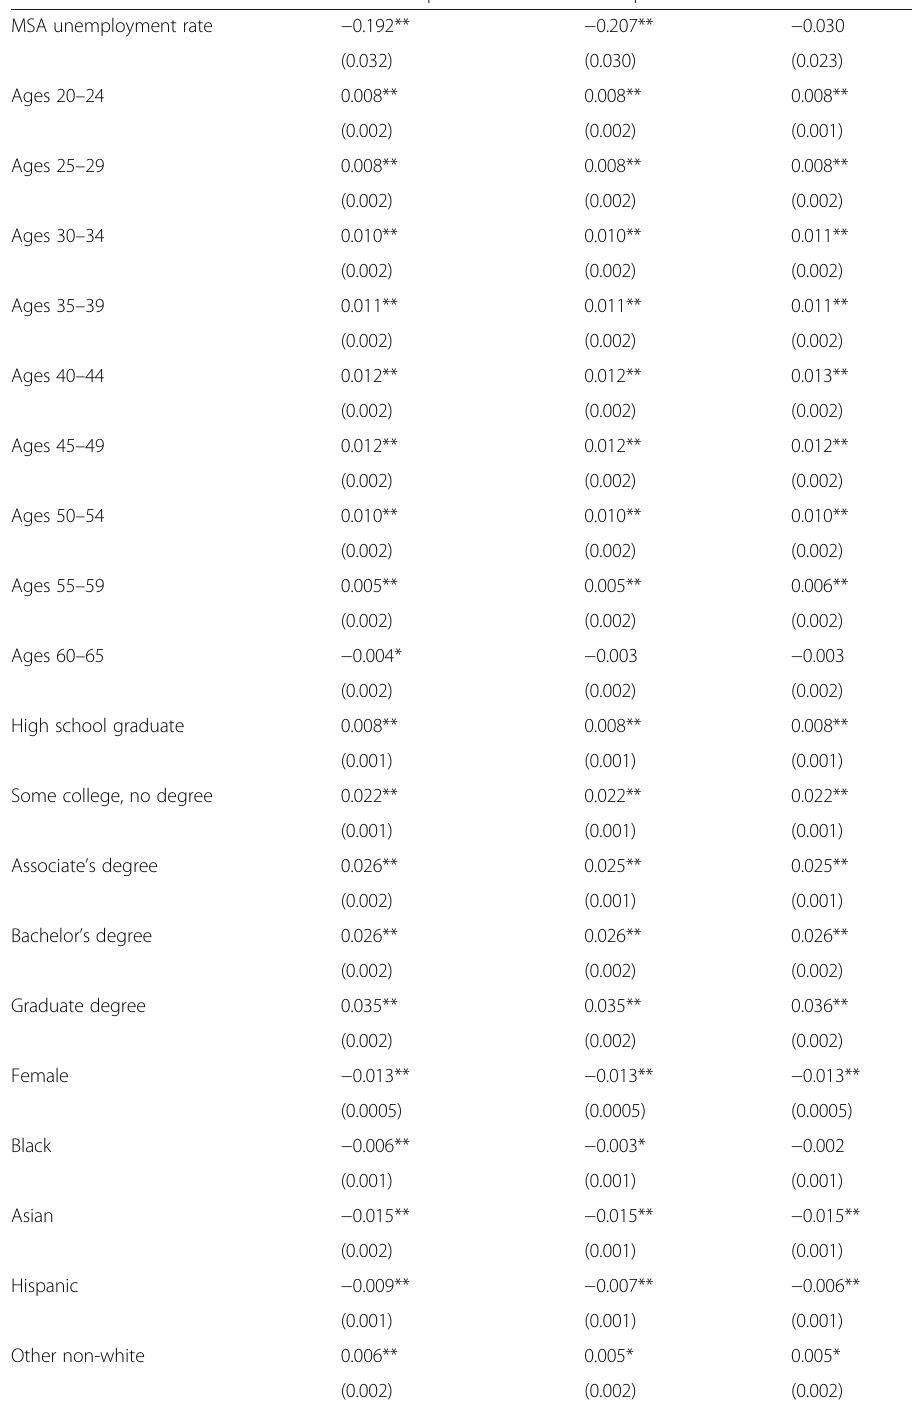
Table 10 Unemployment effects on multiple job holding, full coefficient